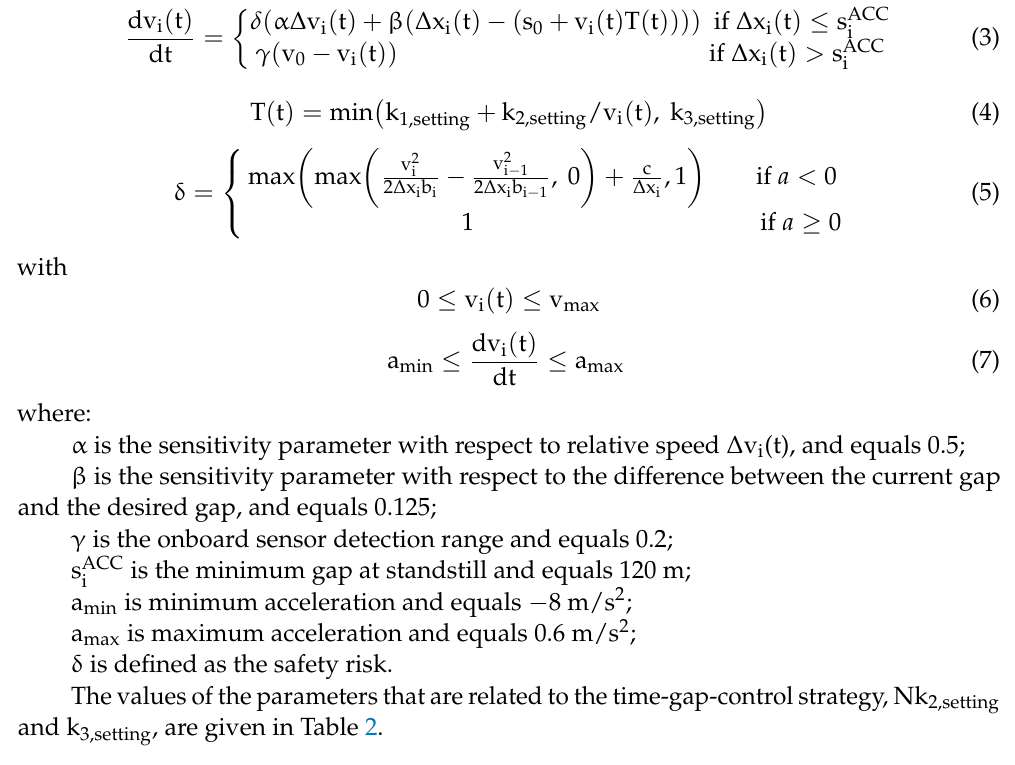
Table 2. k 1,setting , k 2,setting and k 3,setting